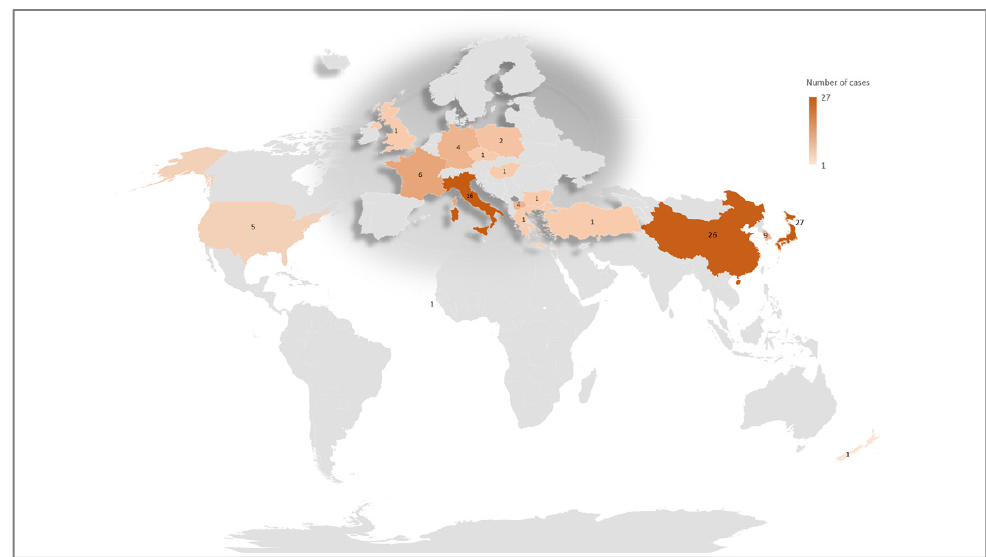
Figure 3. Geographical distribution of DD2 families. Number of cases for each nation are shown in the map. Of the 120 families, 12 cases were not shown in the map due to unknown geographical origin ( n = 5) or to not-well defined nationality ( n = 7).